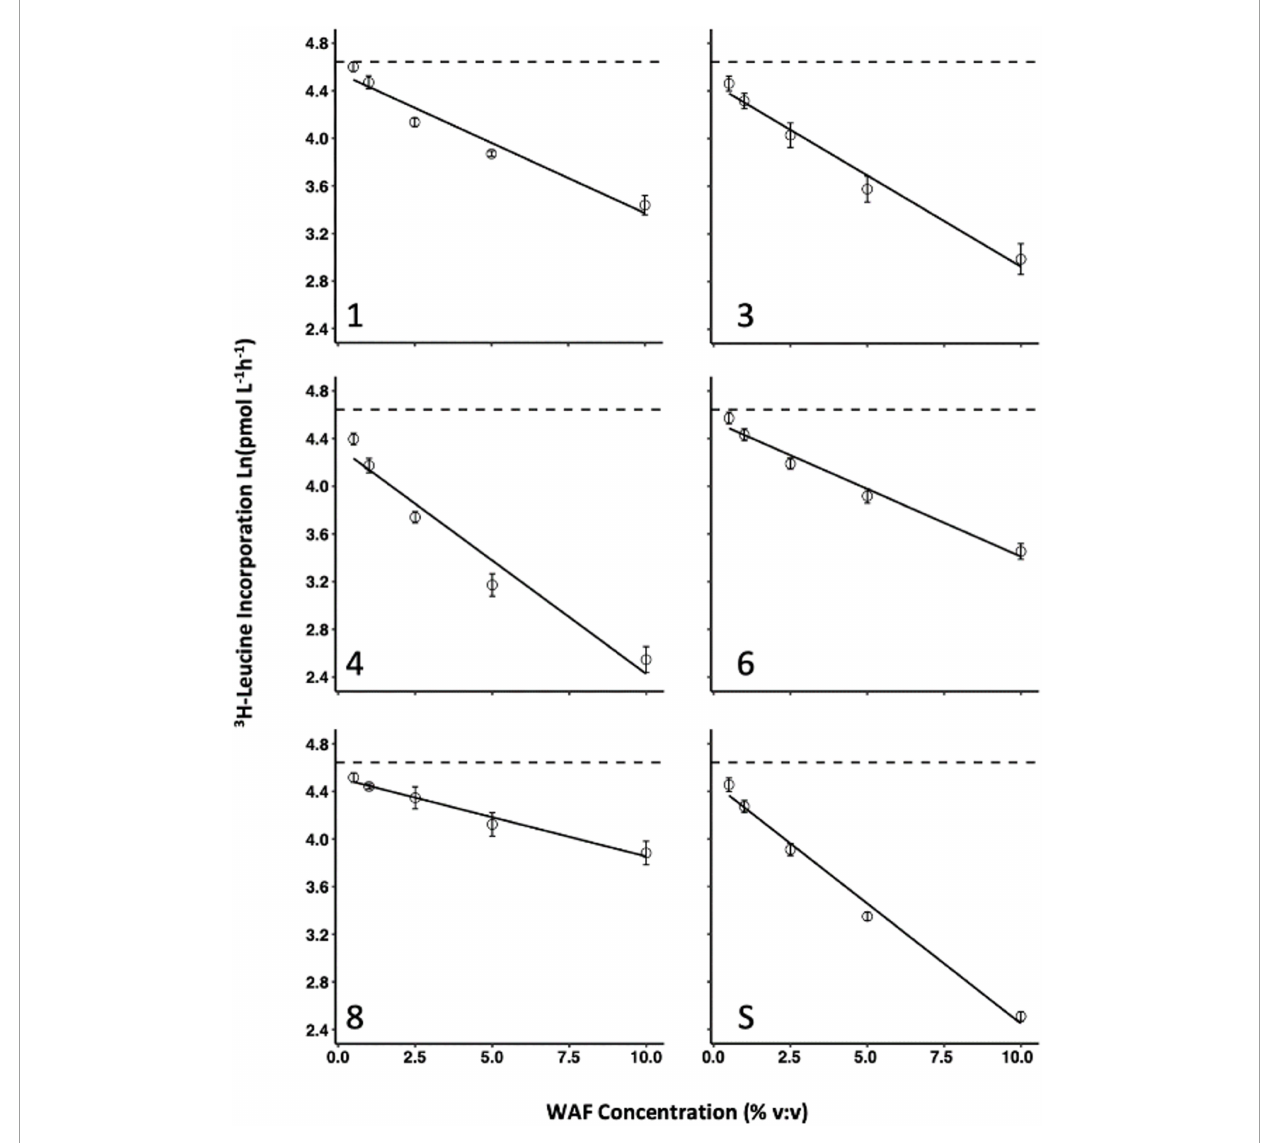
FIGURE2 Bacterial production response to increasing WAF dose for all 6 oils. WAF dose response of bacterial production ( 3 H-Leucine incorporation) for each of the 6 oils used in this study. Error bars represent the standard deviation of the mean of experimental replicates from the same WAF